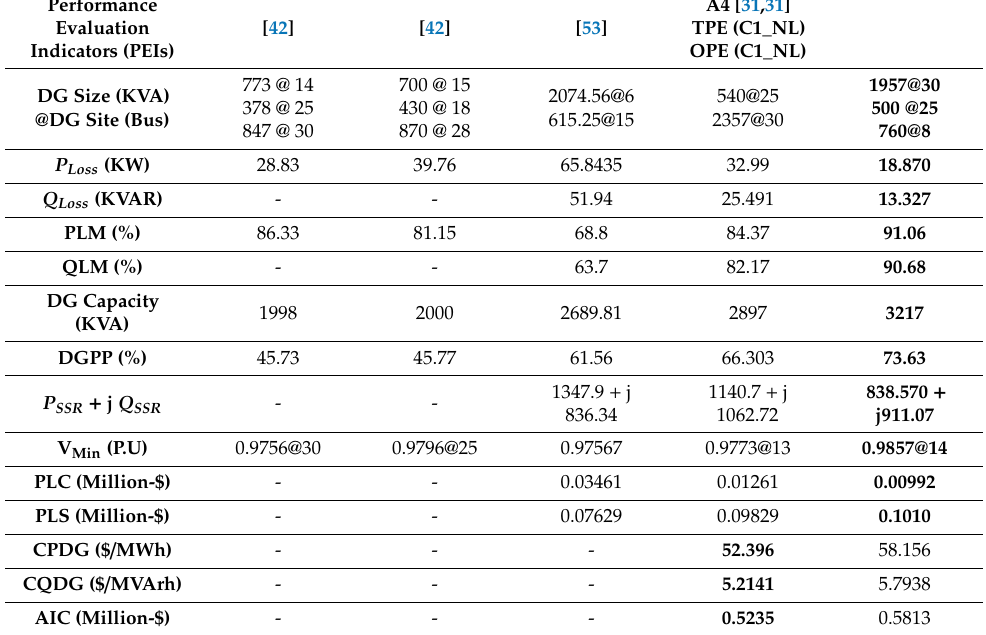
Table 30. Comparisons of results with C1_NL for 33-bus TDN (DG@LPF =